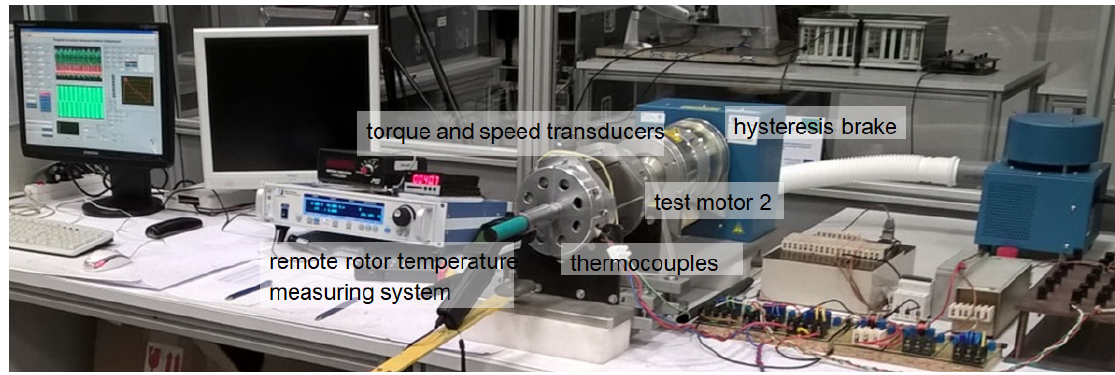
Energies 2021 , 14 , x FOR PEER REVIEW Figure 9. Experimental setup for measurements of core losses in investigated motors with test motor 2.